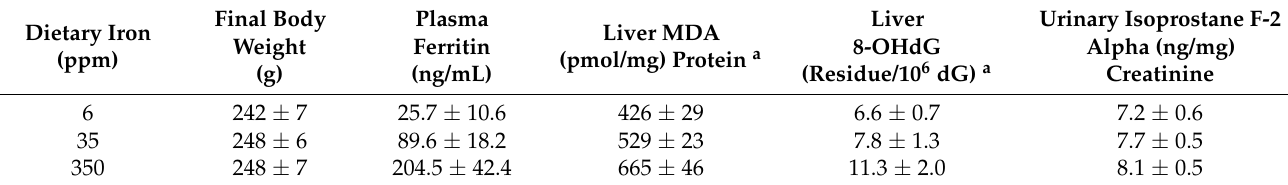
Table 7. Effect of dietary iron on iron status and oxidative stress